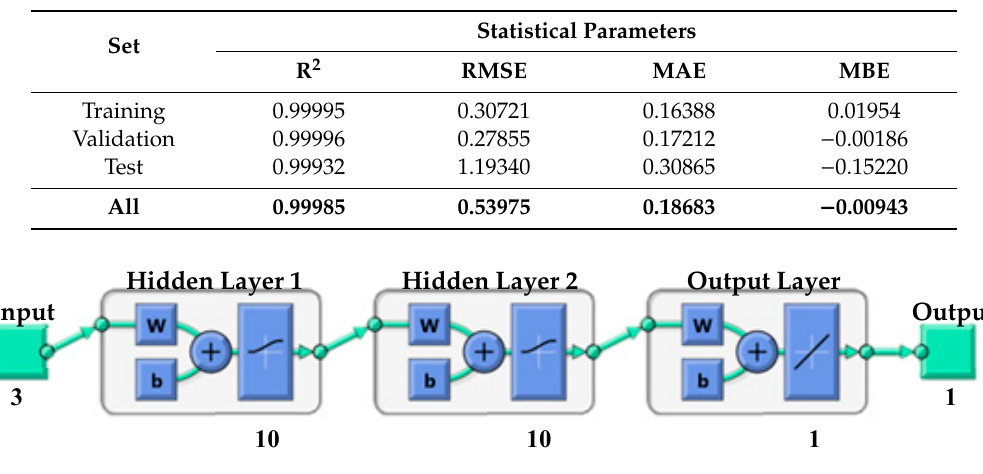
Figure 5. Topology of the selected network.